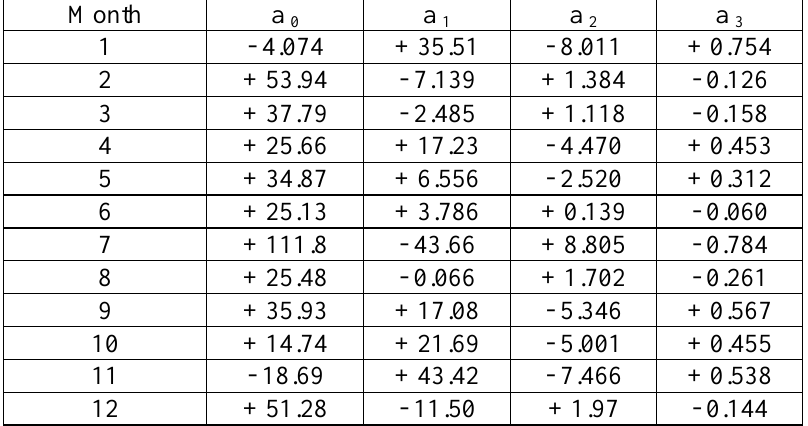
/B ) with days of year mp o